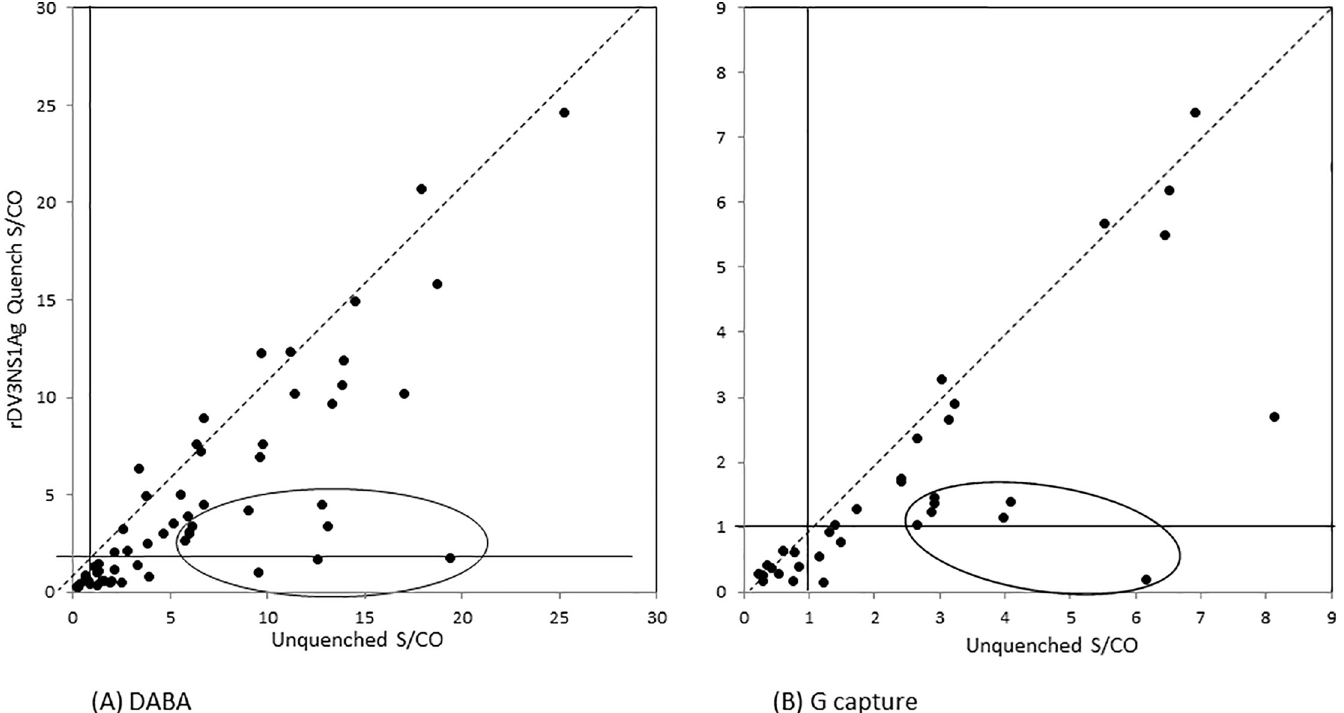
Fig 4. 4A and 4B. G capture and DABA data on Zika confirmed panels comparing DV3NS1Ag quenched and un-quenched conjugates. X by Y plots of sample reactivity from patients known to have been infected with ZKV. Reactivity is expressed as sample to cut off ratios when tested using un-quenched conjugate and rDV3NS1Ag-quenched conjugate. Left hand panel (A) displays the results with 59 ZKV convalescent sera (S ã o Paulo and Rio de Janeiro) tested in the DABA using either unquenched or quenched conjugates. Dotted line is a line of interpolated equivalence assuming no difference in reactivity. Solid lines represent the assay cut off values. Right hand panel (B) similarly displays the reactivity of 41 samples from patients with confirmed ZKV infection tested in the G capture using unquenched and quenched conjugate diluents. Samples from patients with proven ZKV showing a reduced reactivity resulting from the quenched conjugate are circled in both panels.